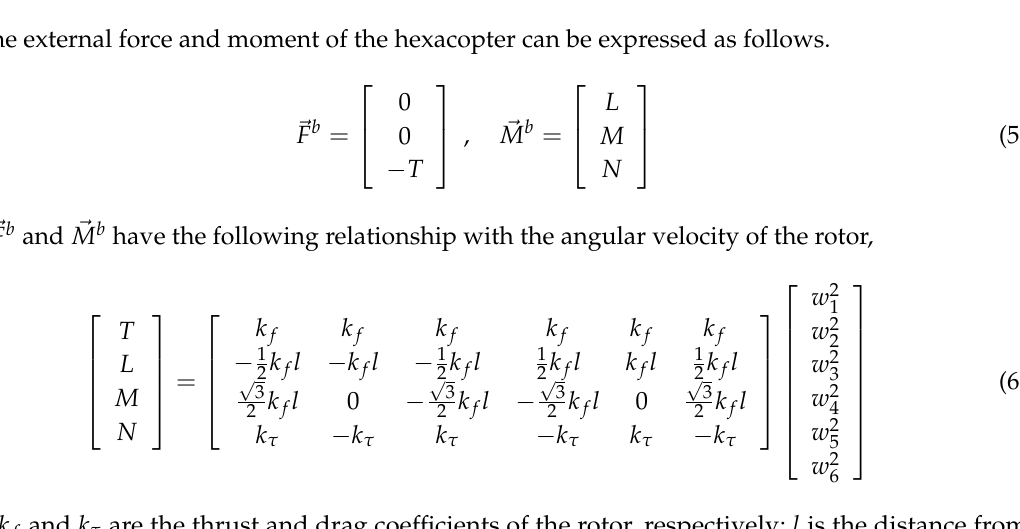
Figure 1. Tarot 680 hexacopter platform and its coordinate